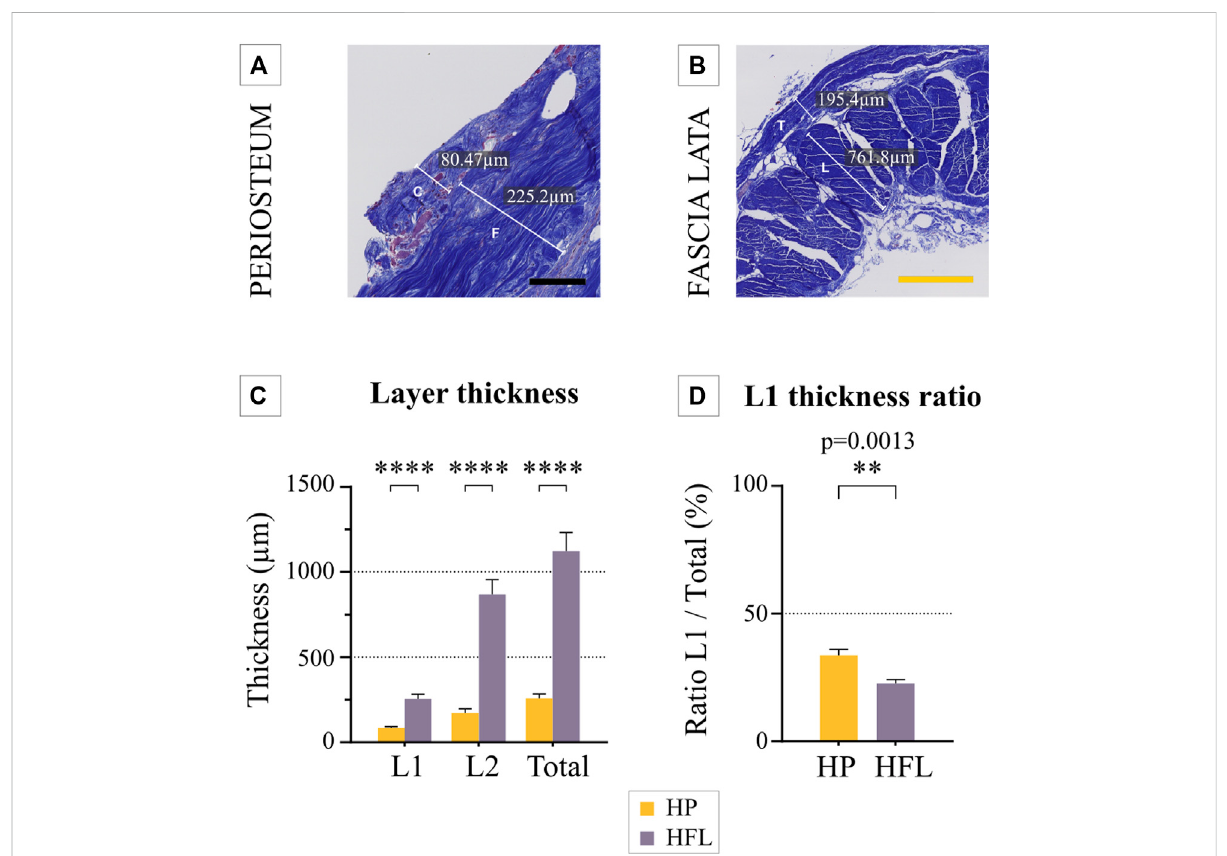
FIGURE 2 Exampleofathicknessmeasurementoftheperiosteum (A) andfascialata (B) .Themeanthicknessofbothtissues( N =4donors)wascompared, along with their respective layers (C) , as well as the ratio of the thinnest layer to total thickness ( N = 4 donors) (D) . C: cambial layer, F: fi brous layer, L: longitudinallayer,T: transverselayer,HP:human periosteum,HFL: humanfascialata, L1:cambialortransverselayer,L2: fi